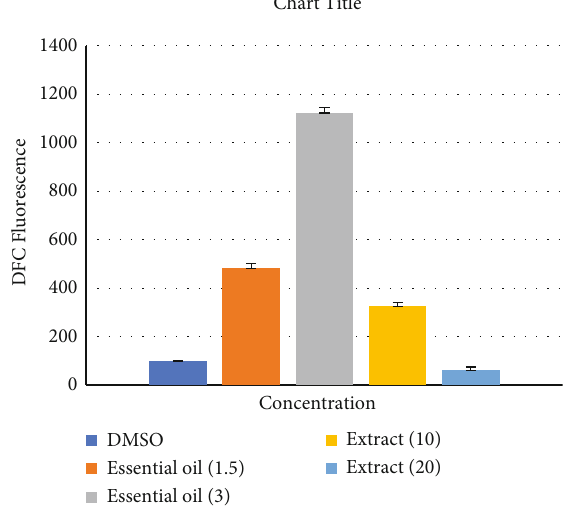
Figure 5: E ff ect of essential oil and aqueous extract of D. ammoniacum oleo-gum resin on the induction of ROS in A549 cells. The bar chart is the average fl uorescence DCF. The results are expressed as mean ± SD of three separate experiments. ∗ p < : 05 and ∗∗ p < : 01 were considered signi fi cant,